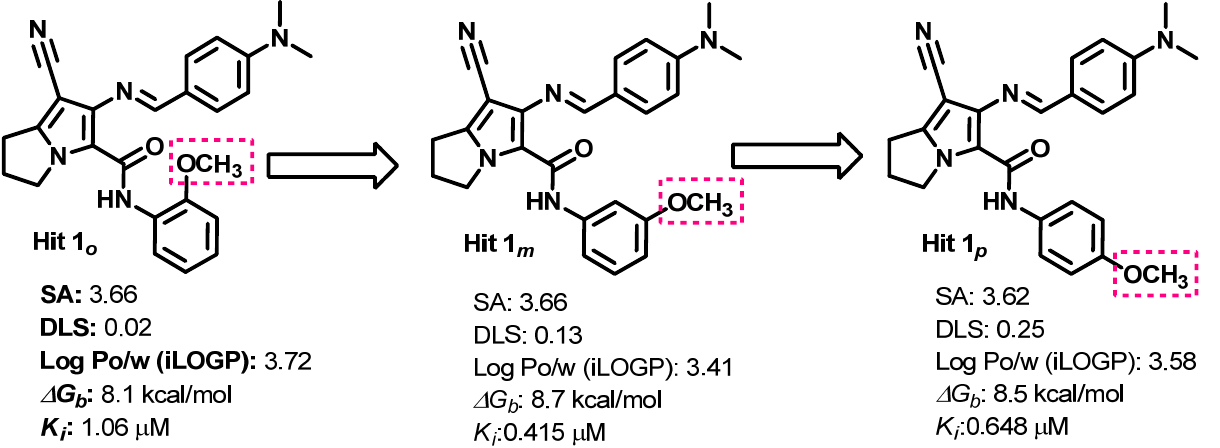
Figure 8. Effect of changing the position of OCH 3 group on SA, DLS, ClogP values, binding affinities ( Δ G b ), and inhibition constants (K i ) of hits 1 o,m,p .